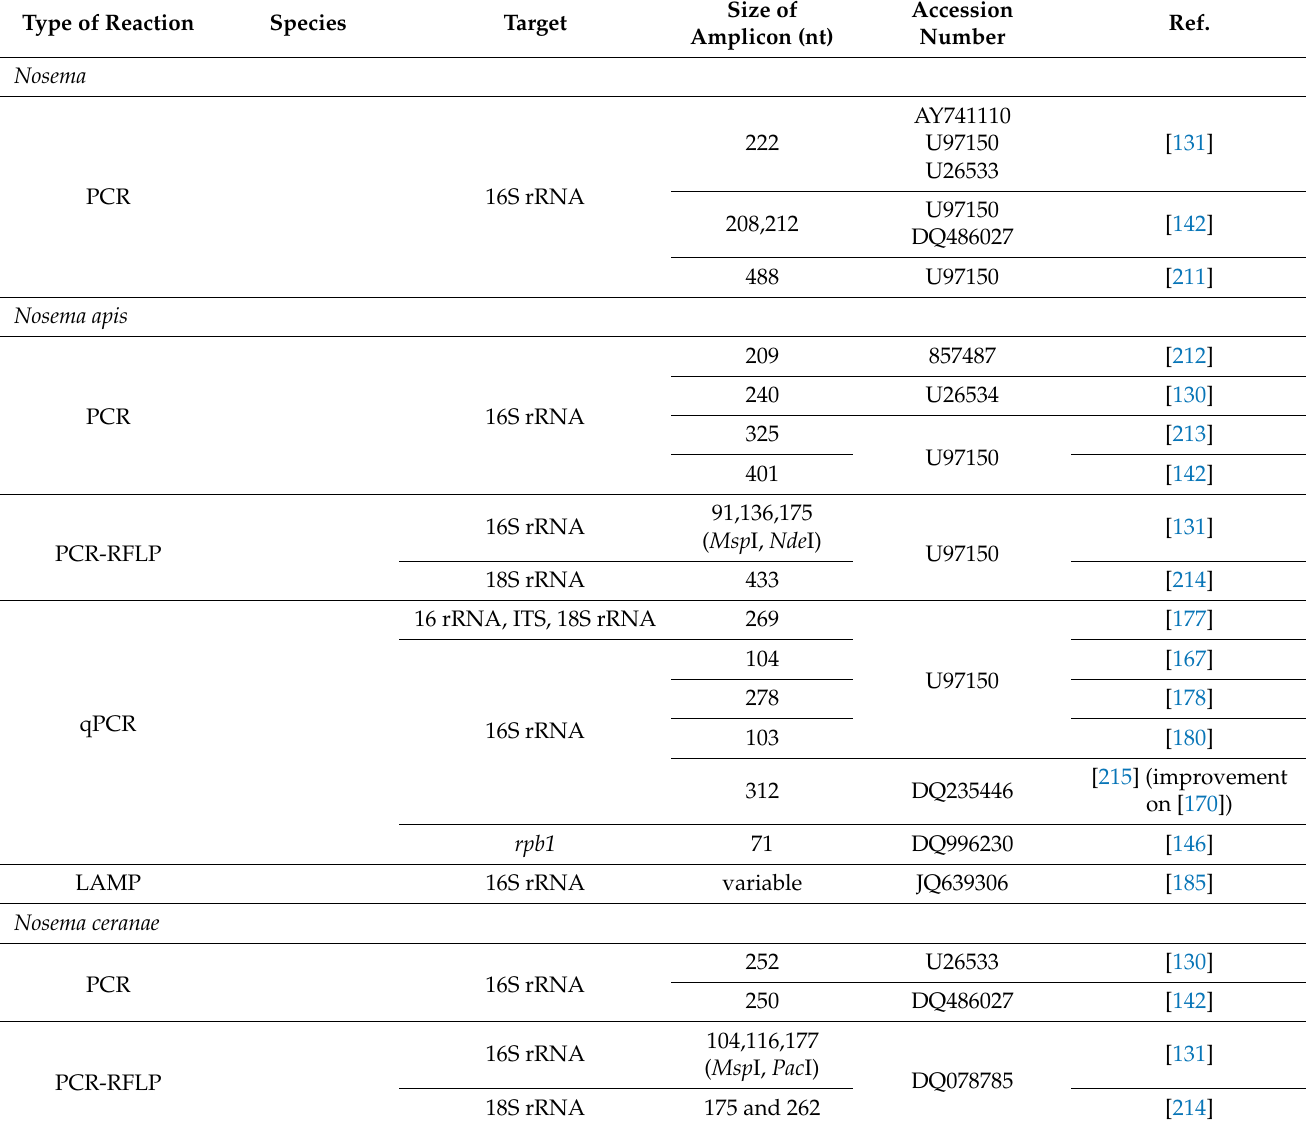
Table 2. Molecular assays for the detection and differentiation of fungal pathogens of the